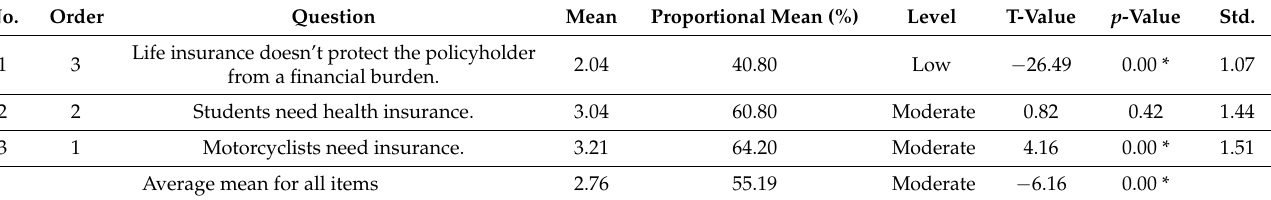
Table 8. Insurance: Mean and std. values for financial literacy levels ( n =